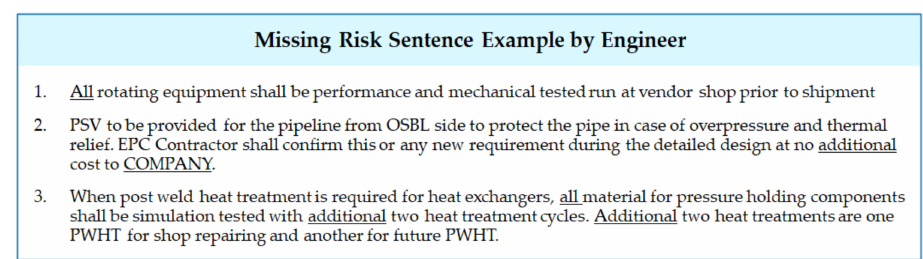
Table 9. Analysis time results of the TRE module.